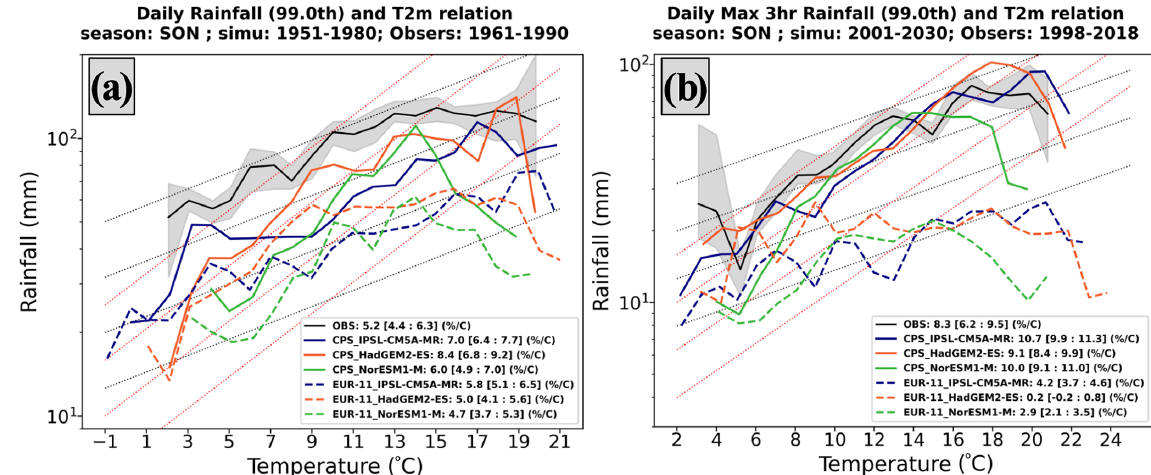
Figure 6. Extreme (99th percentile) daily precipitation (a) and daily maximum 3-hourly rainfall (b) in scaling with daily temperature at 2m from simulations (1951–1980 for daily rainfall and 2001–2030 for 3-hourly rainfall) and in situ observations (1961–1990 for daily rainfall and 1998–2018 for 3-hourly rainfall); the black dotted lines show the Clausius–Clapeyron relation, the red dotted lines show the super Clausius–Clapeyron relation, and the grey band denotes the 90% confidence interval of observational